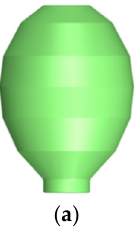
Figure 14. CAD model and global template point cloud of the hull ‘a’: ( a ) CAD model; ( b ) Global template point cloud.